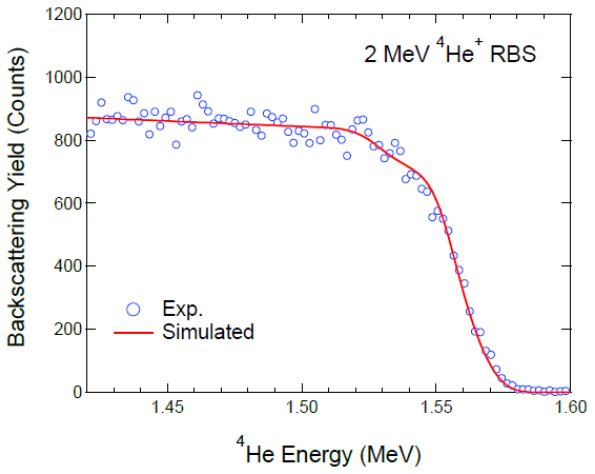
Figure 3. RBS spectrum of the sample before irradiation (blue open circles). A simulated spectrum (red solid line) is also